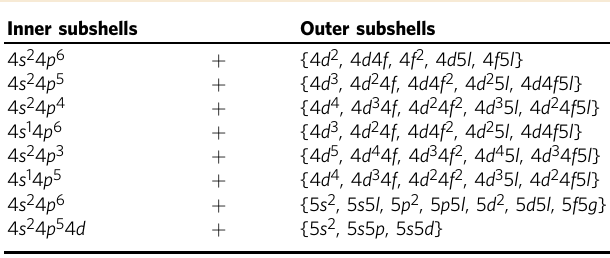
Table 1 Con fi guration